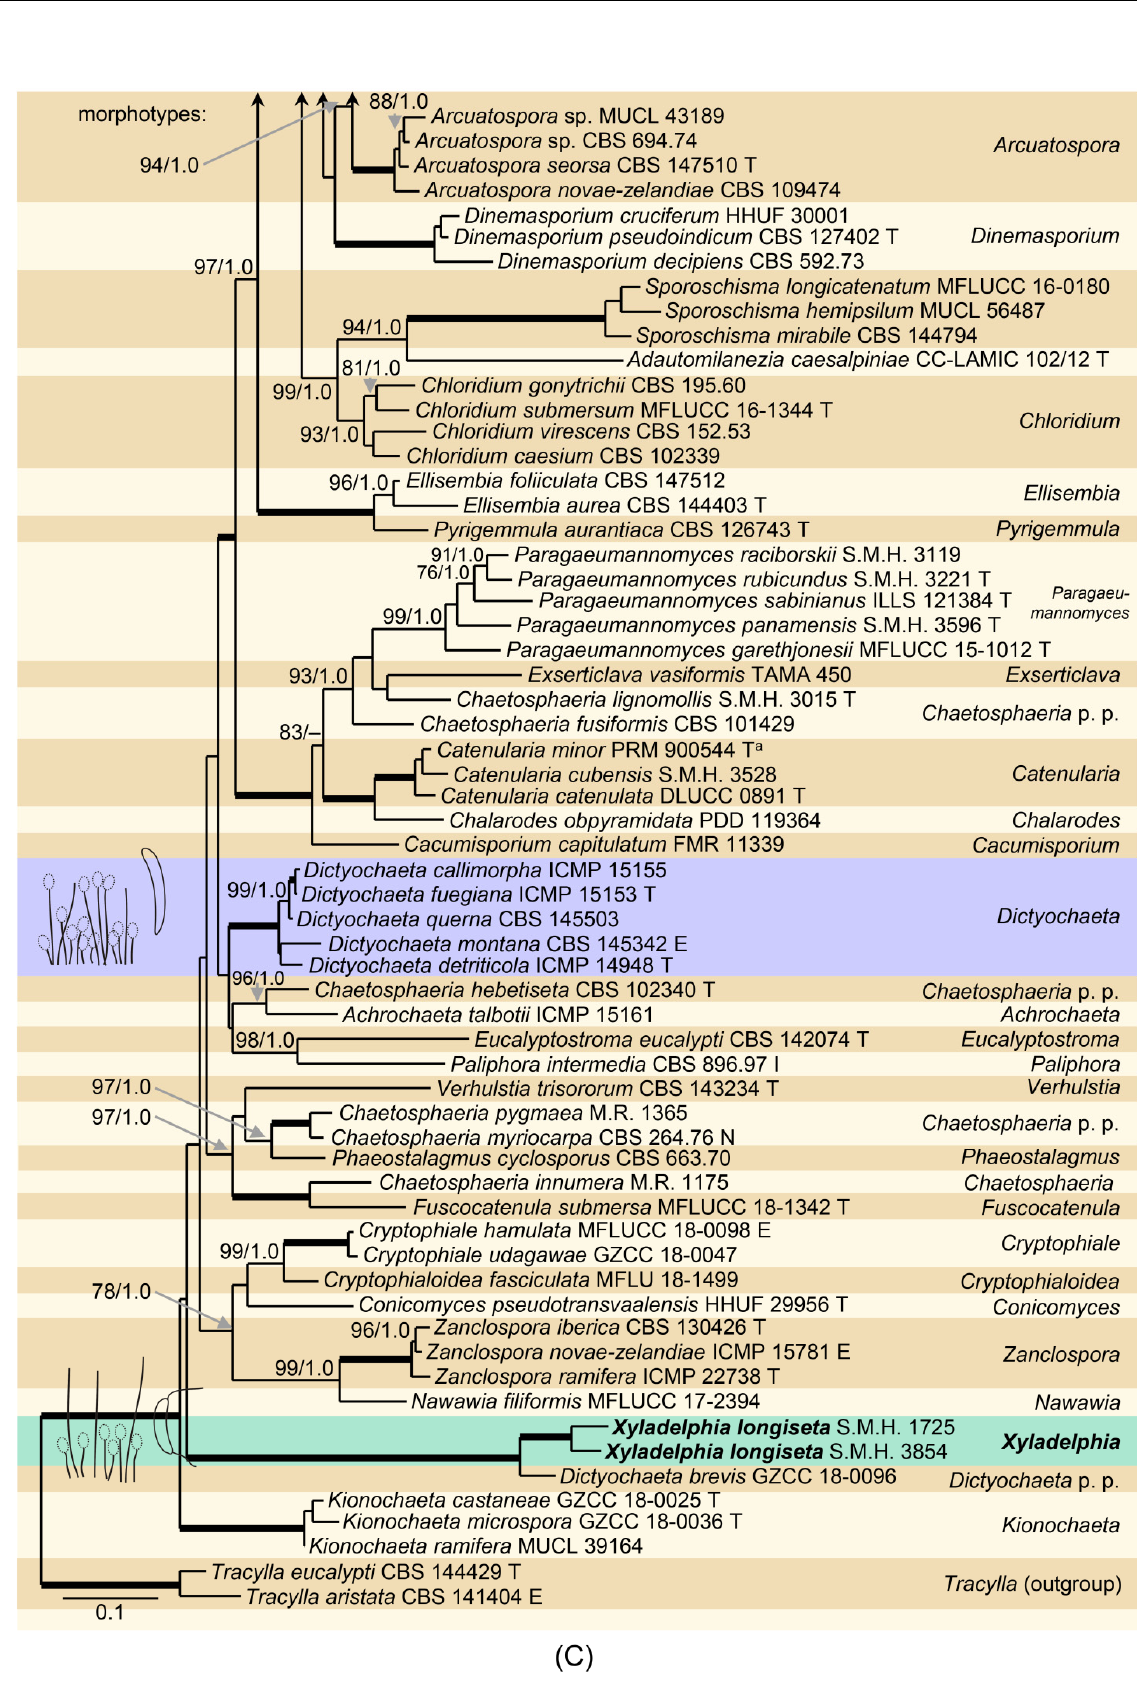
Figure 2. ( A ) Phylogenetic tree based on the combined ITS-28S- tef1- α rDNA sequences constructed by maximum likelihood (RAxML) of members of the Chaetosphaeriaceae. Species names given in bold and placed in green boxes are